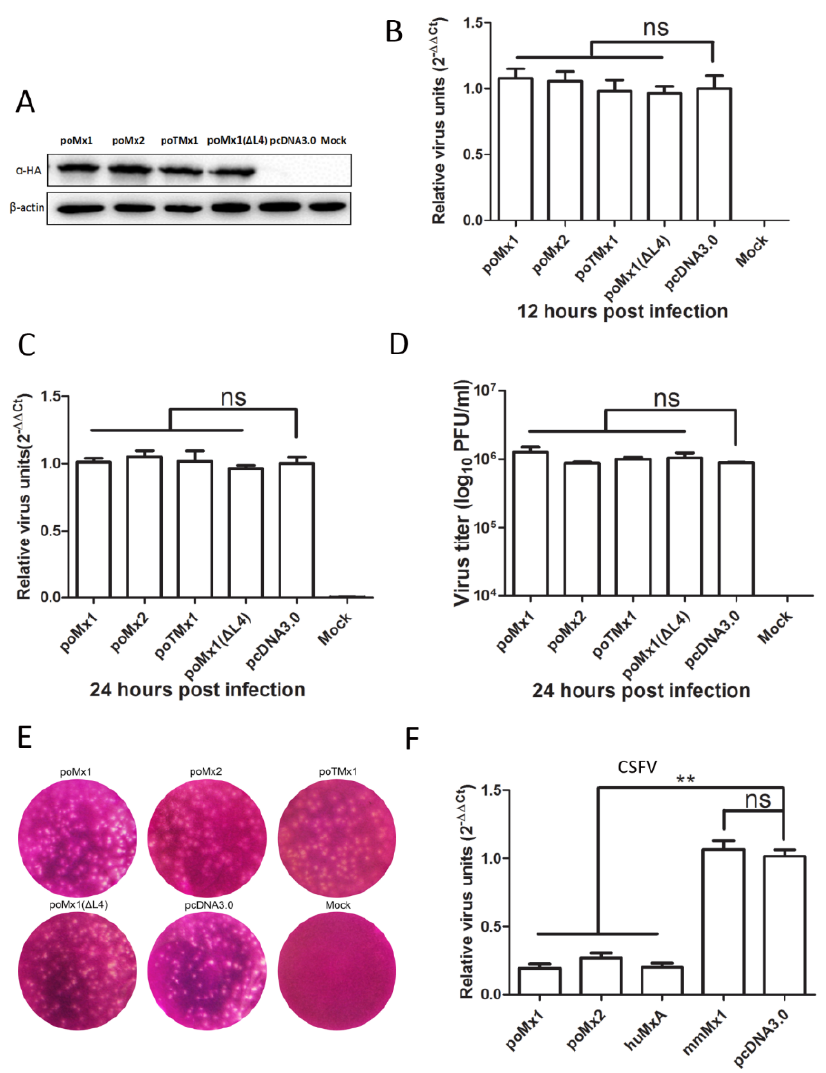
Figure 4. The different isoforms of porcine Mx proteins have no anti-JEV activity. ( A ) Western blot analysis of the lysates of PK-15 cells transfected with the indicated constructs. Overexpression of the different porcine Mx proteins was determined using anti-HA Flag mouse monoclonal antibody; ( B , C ) PK-15 cells were transfected with these constructs and infected with JEV at an MOI of 0.05. At 12 and 24 hpi, JEV replication was analyzed by RT-qPCR; ( D , E ) At 24 hpi, JEV replication was analyzed by plaque assay; ( F ) Classic swine fever virus (CSFV) replication (positive control) was inhibited by some exogenous Mx proteins. All data are presented as means ± standard deviation (S.D.) as indicated. Statistical significance is indicated as ns ( p > 0.05) and ** ( p < 0.01).